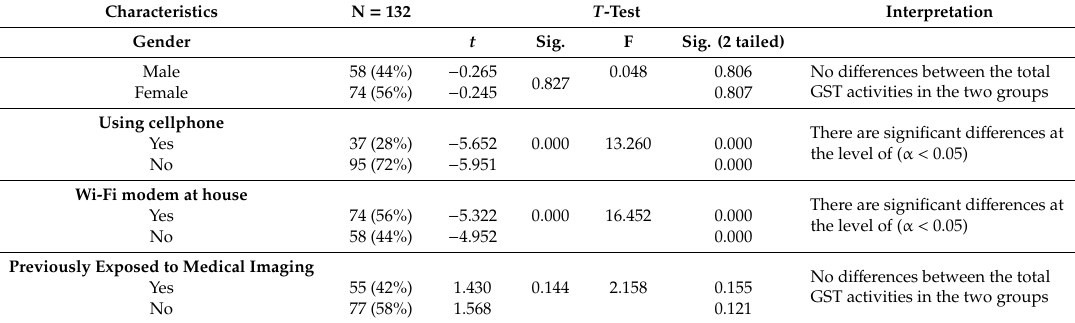
Table 3. Demographic characteristics of study volunteers.